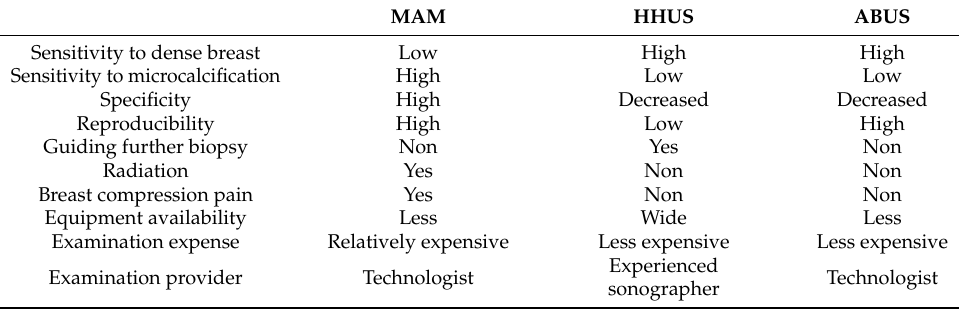
Table 1. Comparison of MAM, HHUS, and ABUS for BC